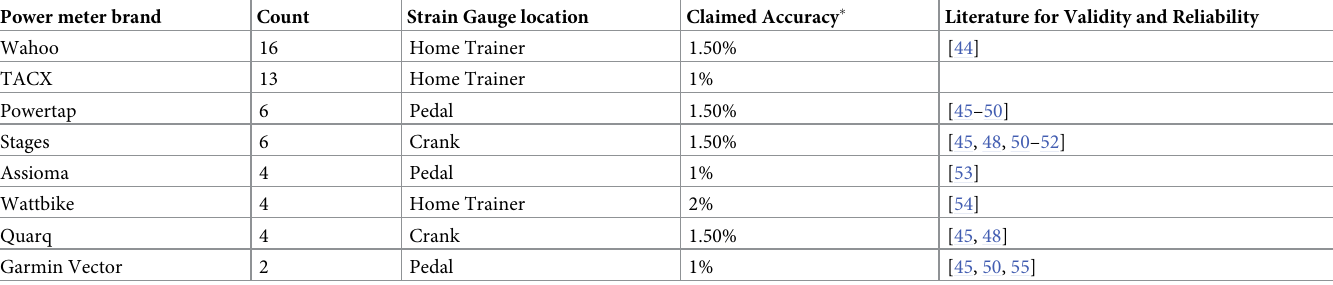
Table 3. Distribution of power meter utilisation by participants and literature to support validity and reliability of each